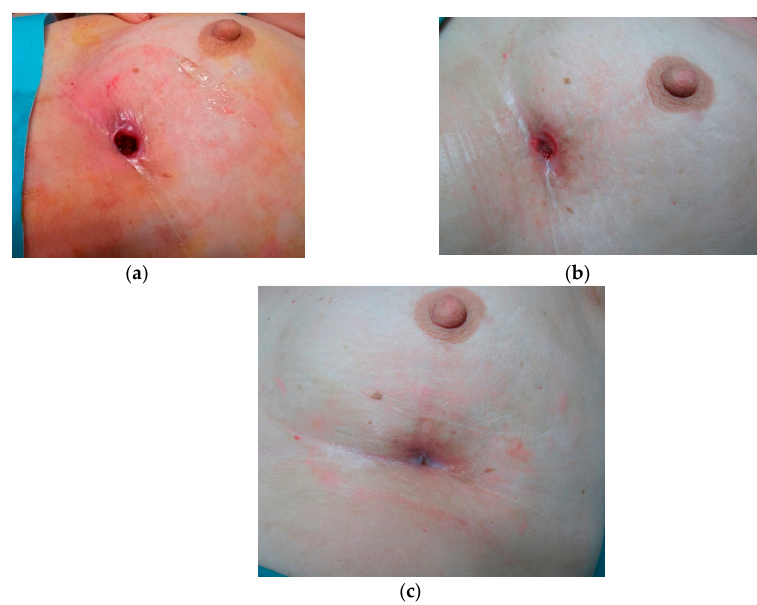
Figure 5. Patient receiving conservative treatment for breast cancer who required 4 PRP treatments for the wound to heal. ( a ) pretreatment, ( b ) 6 weeks, ( c ) wound closure. J. Clin. Med. 2020 , 9 , x FOR PEER REVIEW